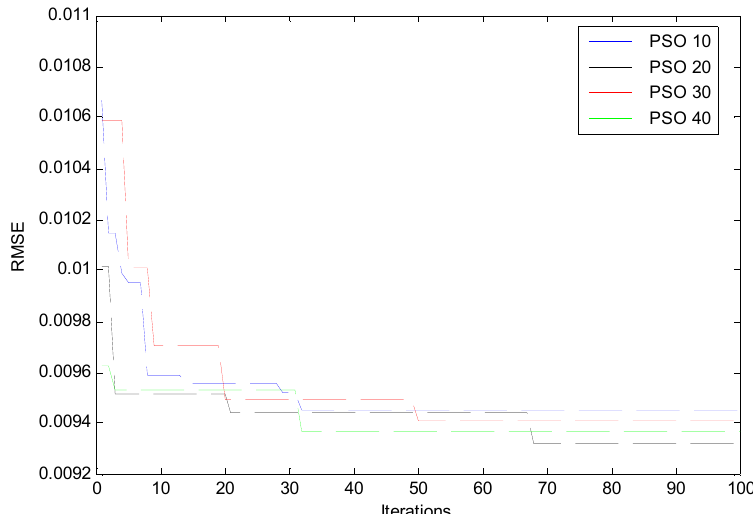
Figure 6. RMSE value of the hybrid PSO-ANN at different population sizes.